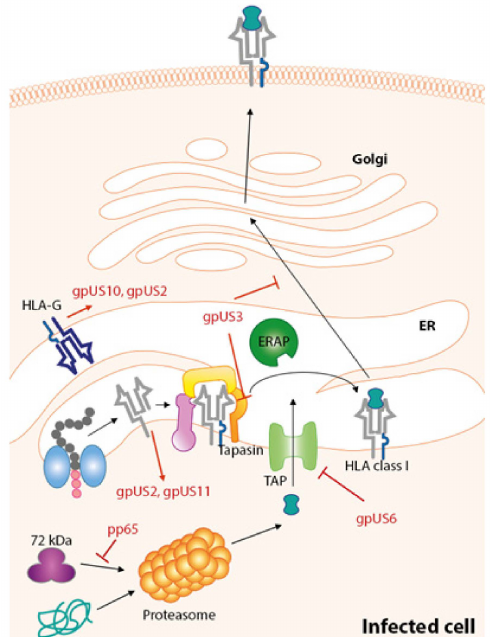
Figure 2. HCMV-mediated downregulation of HLA-class I pathway. The protein pp65 prevents the presentation of IE-derived peptides. Glycoprotein unique short 2 (gpUS2) and US11 (gpUS11) redirect HLA class I heavy chain (hc) from the endoplasmic reticulum (ER) to the cytosol and induce the proteasomal degradation of the molecule. Glycoprotein US6 (gpUS6) inhibits the function of transporter associated with antigen processing (TAP). Glycoprotein US3 (gpUS3) inhibits the tapasin-dependent peptide loading and retains HLA class I molecules in the endoplasmic reticulum (ER). Glycoprotein US10 (gpUS10) retains HLA class I hc in the ER. gpUS10 and gpUS2 induce degradation of